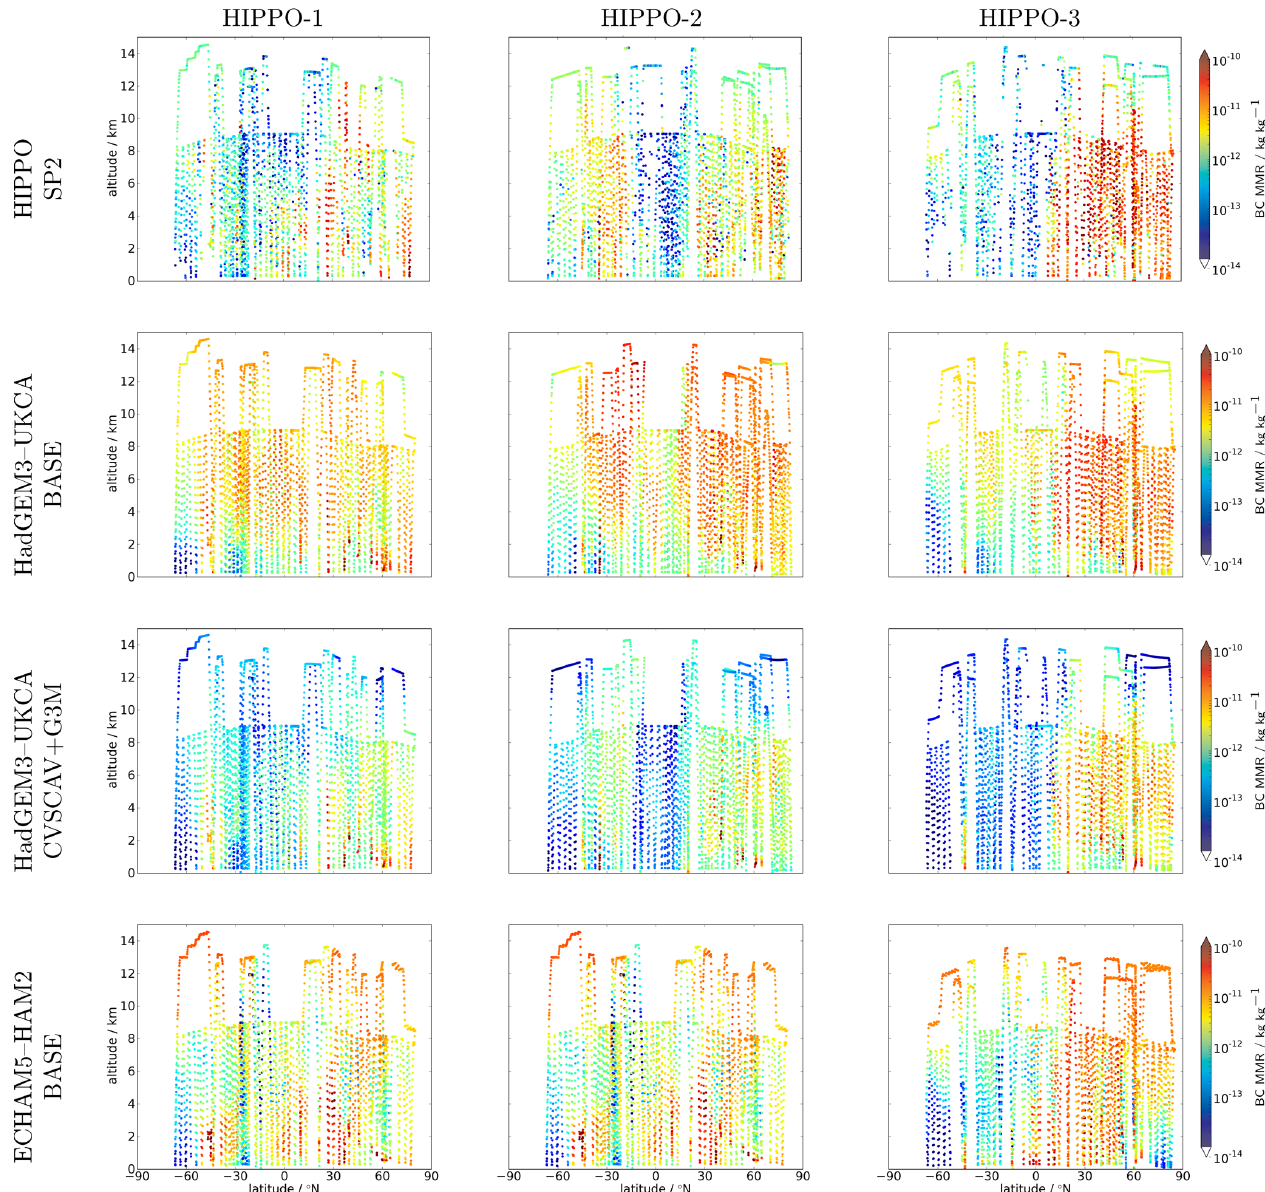
Fig. 2. Mass mixing ratio (kgkg − 1 ) of BC in the atmosphere, from each phase of the HIPPO campaign, calculated by aggregating SP2 data over 1-minute intervals, and from nudged HadGEM3–UKCA (BASE and CVSCAV) and ECHAM5–HAM2 (BASE) simulations, sampled along the HIPPO flight track (also at 1-min